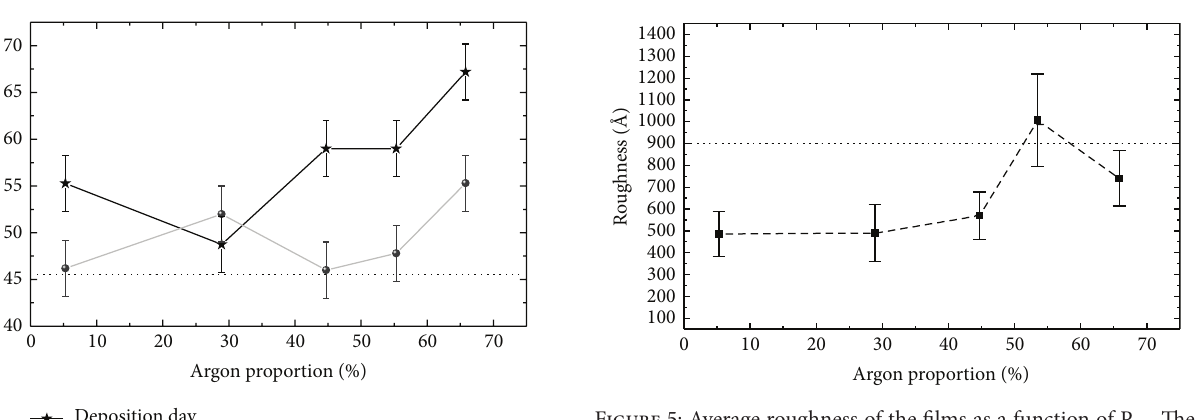
Figure 5: Average roughness of the films as a function of P Ar . The roughness value for the noncoated PVC plate is represented by the horizontal dotted